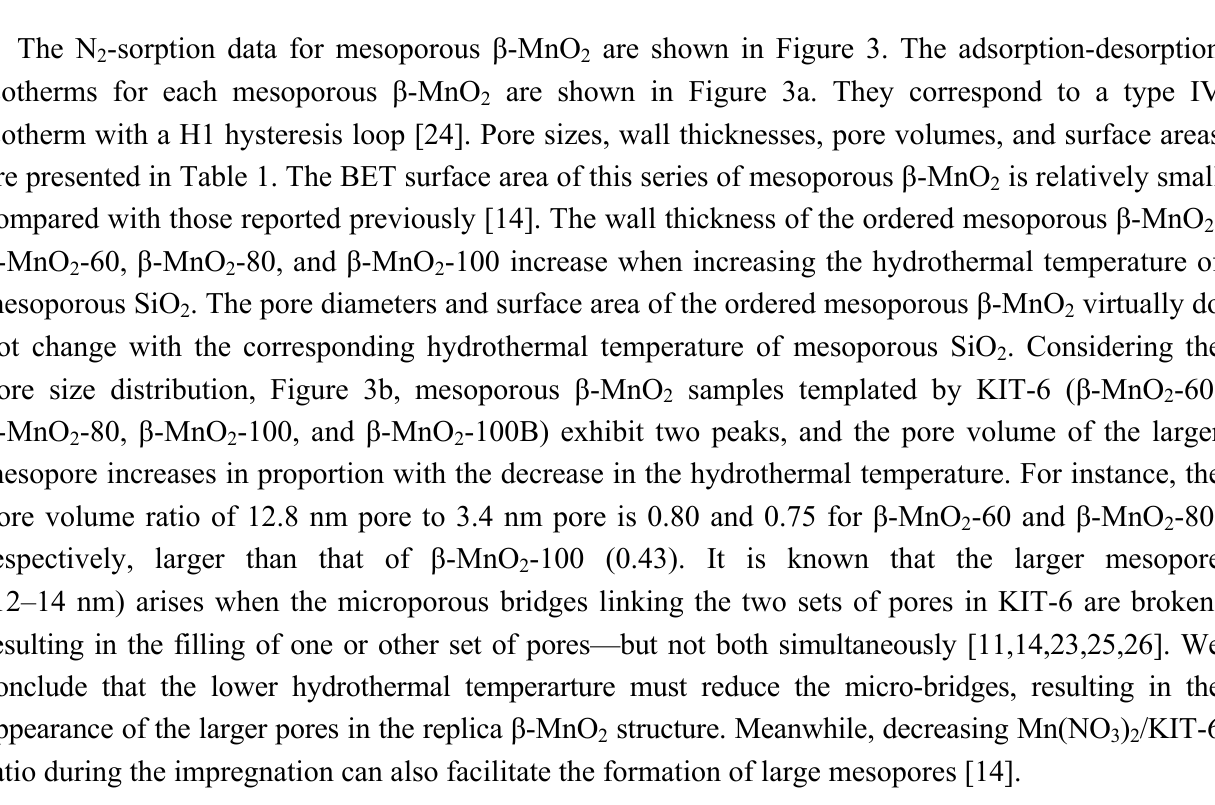
Figure 3. N adsorption-desorption isotherms ( a ) and pore size distributions ( b ) for the 2 materials using different silica as the crystalline mesoporous β -MnO 2